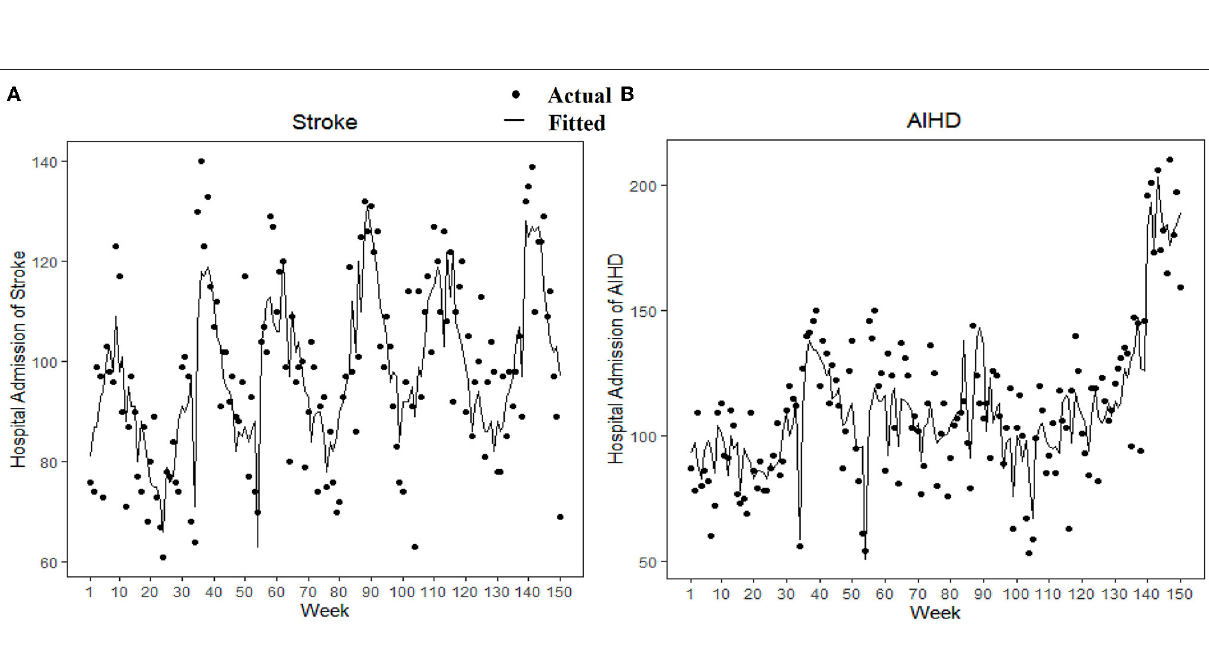
FIGURE 2 | The actual distribution and GAM model fitting trends of weekly hospital admissions for stroke and AIHD. Points indicate the actual number of hospital admissions per week, and the line represents the number of weekly hospitalizations fitted by the GAM model. AIHD, acute ischemic heart disease; GAM: Generalized additive